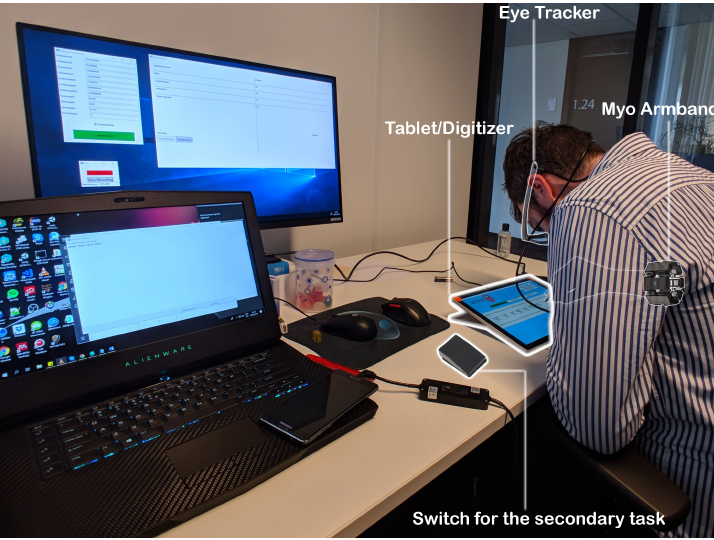
Figure 1. System Model for supporting the framework.